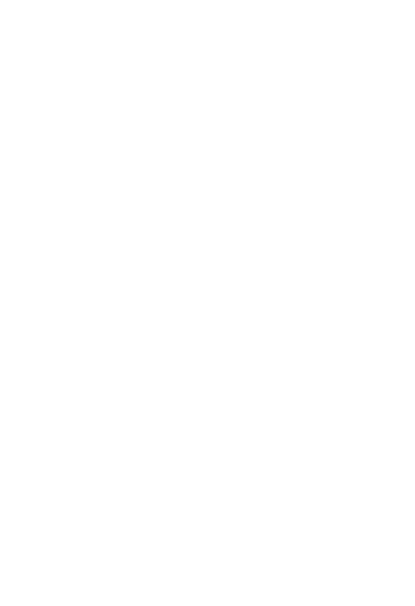
Fig 2. An overview of identified themes, categories, and